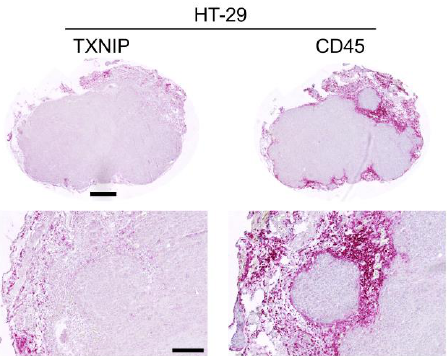
Figure 4. Thioredoxin interacting protein (TXNIP) and CD45 immunostaining results in a HT-29 mouse xenograft tumor. Scale bar (upper panel) = 500 µm, scale bar (lower panel) = 200 µm. Cancers 2020 , 12 Leukocyte infiltration was also assessed in the patient-derived tumor samples of the TMA. The percentage of tumor samples with TXNIP positive versus negative leukocytes in the connective tissues was assessed (Table 1). The results vary between 80% in prostate adenocarcinoma samples and 0% in tumors of the adrenal gland. The informative value, however, might be limited, because, due to the production process of the TMA, the proportion of connective tissues per spot was only small.